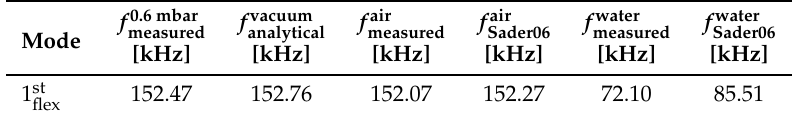
Table 1. Comparison between the experimentally measured and theoretical [21] fundamental frequency of the NCLR cantilever in different environments.